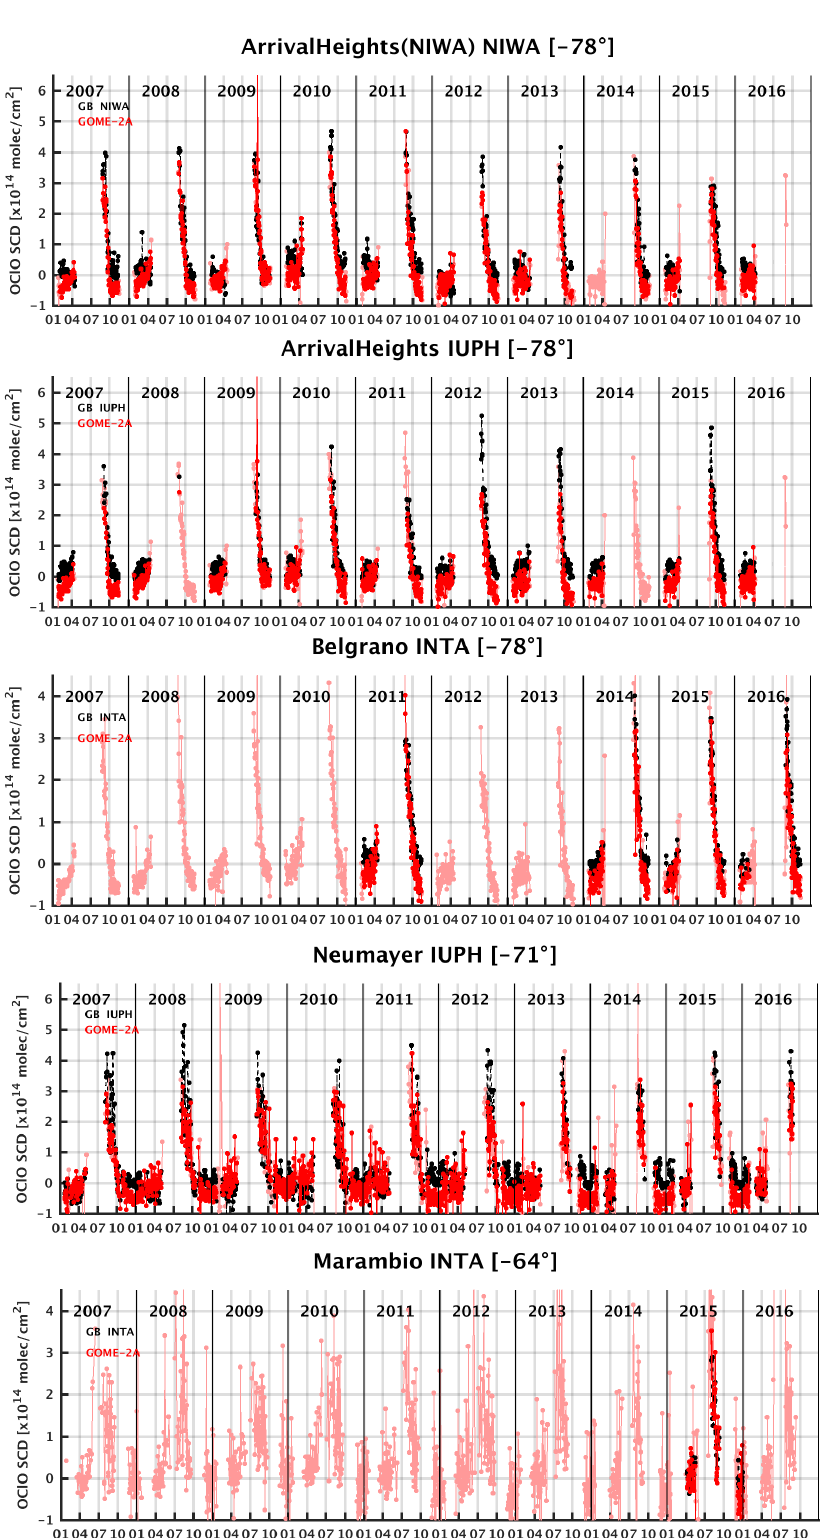
Figure 9. Time series of GOME-2A (red) OClO daily mean slant column data co-located with ground-based (black) measurements performed at each Antarctic station.The lighter transparent red color is used for GOME-2A when there are no ground-based measurements. Please note that in some cases some GOME-2A points lie below the x axis limit of − 1 × 10 14 and down to − 3 . 5 × 10 14 molec.cm − 2 , especially from 2011 onward (e.g., in the case of Neumayer, this represents 27 data points over a total of 1536). Atmos. Meas. Tech., 15, 3439–3463,